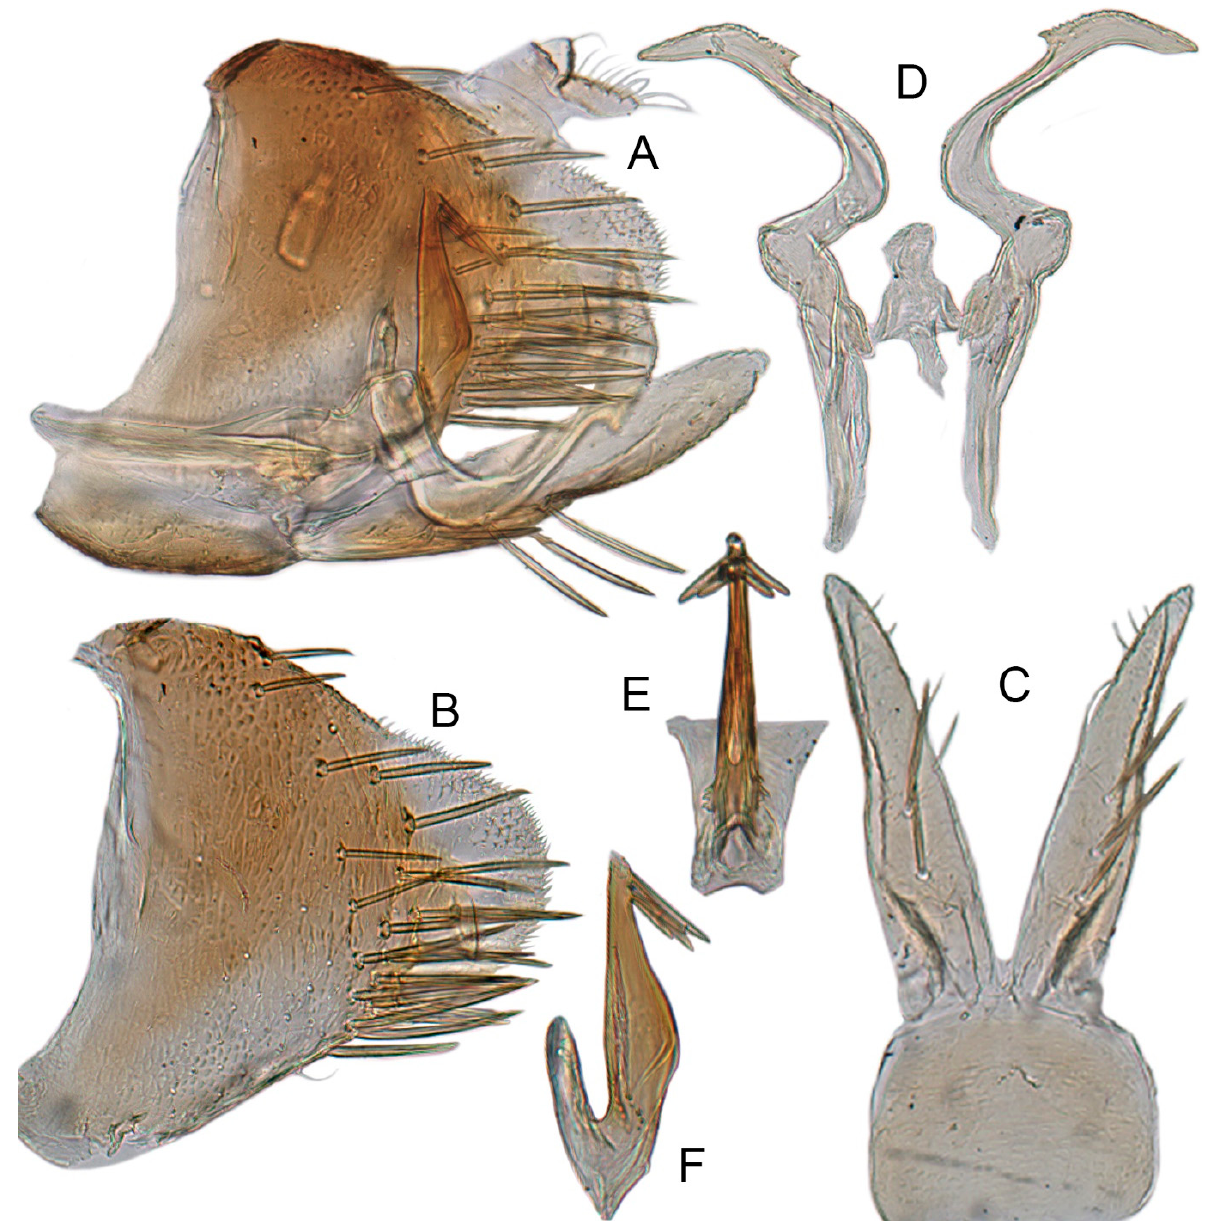
Figure 10. Xestocephalus densprint sp. nov. ( A ) Male genital capsule, lateral view; ( B ) pygofer lobe, lateral view; ( C ) sub- genital plates and valve, ventral view; ( D ) style and connective, ventral view; ( E ) aedeagus, posterior view; ( F ) aedeagus, lateral view.